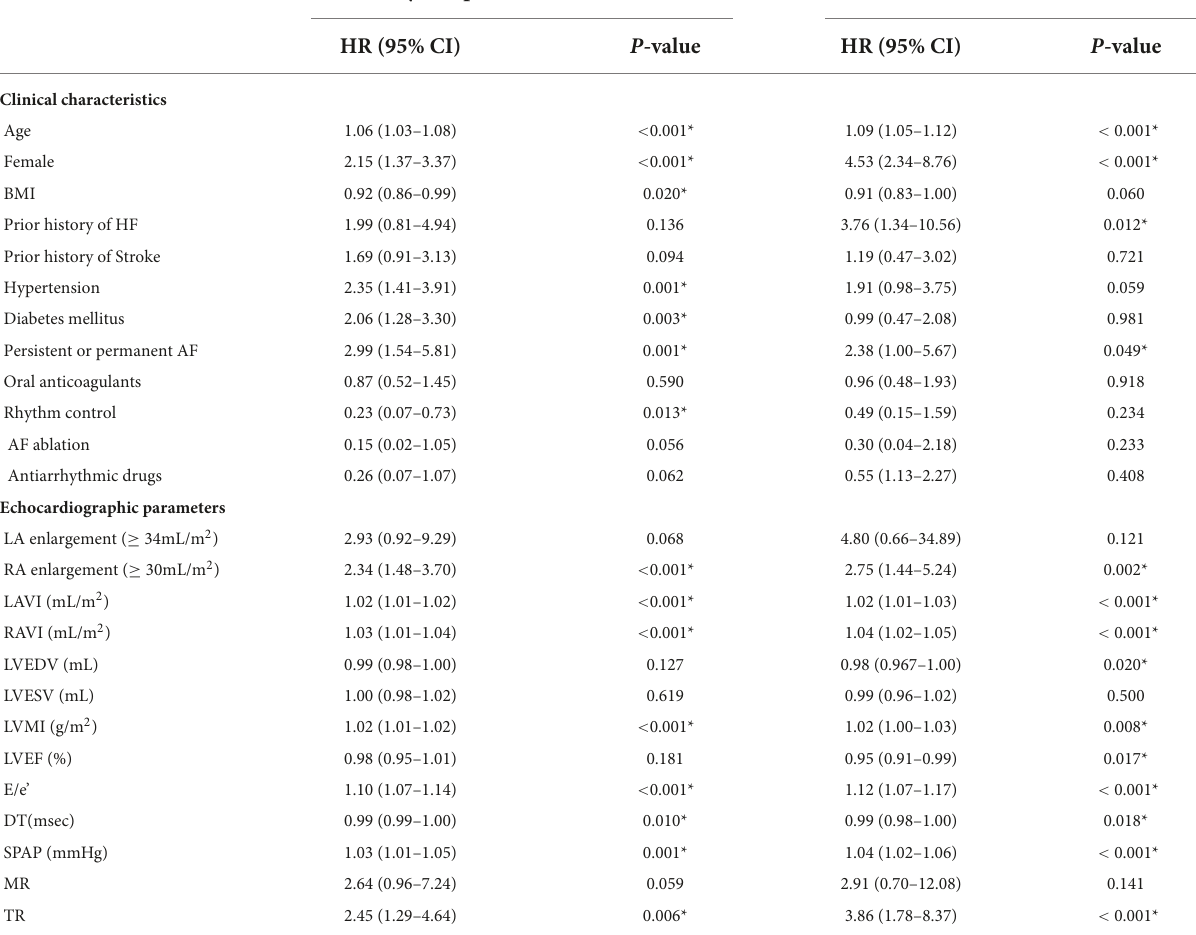
TABLE 2 Univariate Cox proportional hazard analysis for primary composite outcomes of HHF, stroke, systemic embolism or all cause death, and composite end-point of HHF or all cause